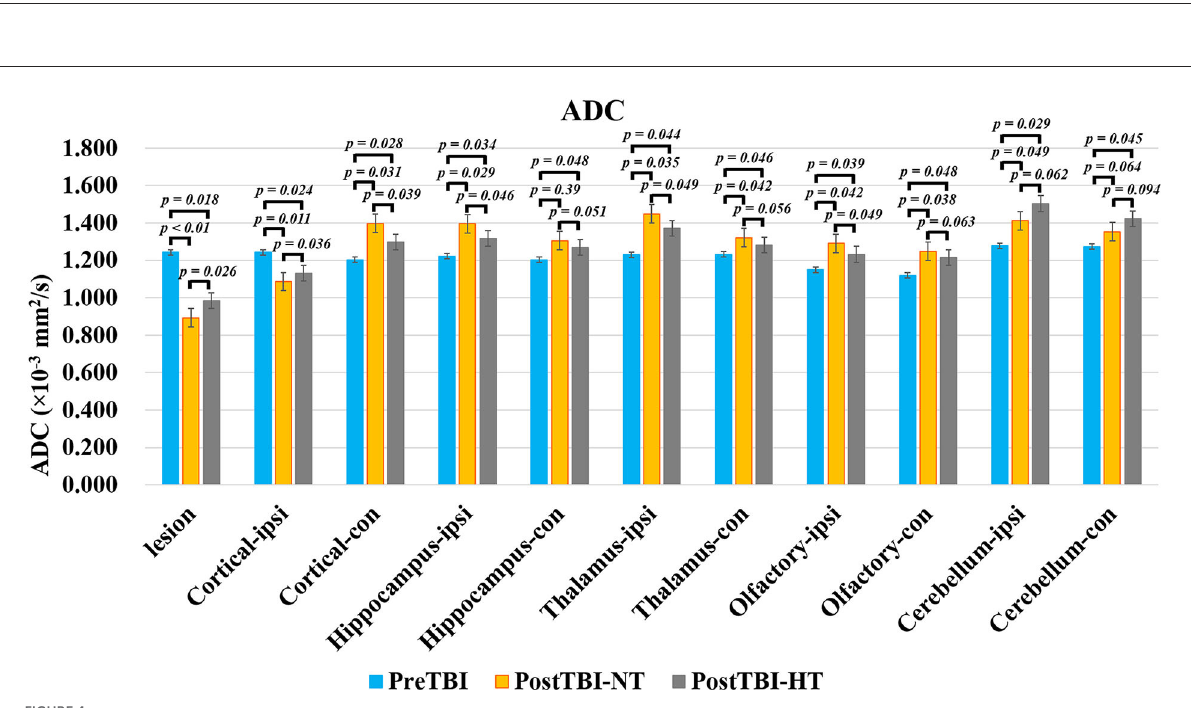
FIGURE4 The quantitative analysis of ADC value on ipsilateral and contralateral brain subregion of TBI impacted by hypothermia and normothermia. The ADC map was derived from the DWI sequence acquired before TBI and 12h after. Data in Figure 11: TBI-NT n = 8, TBI-HT n = 8. All n values refer to the number of rats used, and the error bars depict the mean ± s.e.m. One-way ANOVA calculated P -values with Bonferroni’s multiple comparison test, and P < 0.05 indicates significance. Contra, contralateral hemisphere; ipsi, ipsilateral